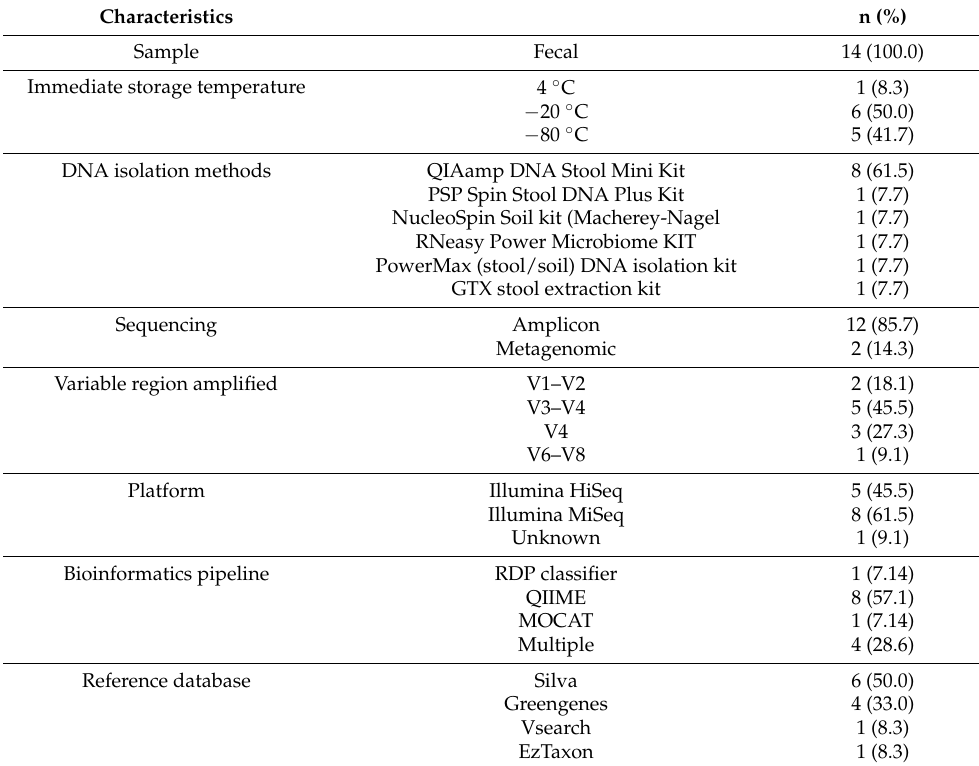
Table 3. Methodological characteristics of included studies (n =